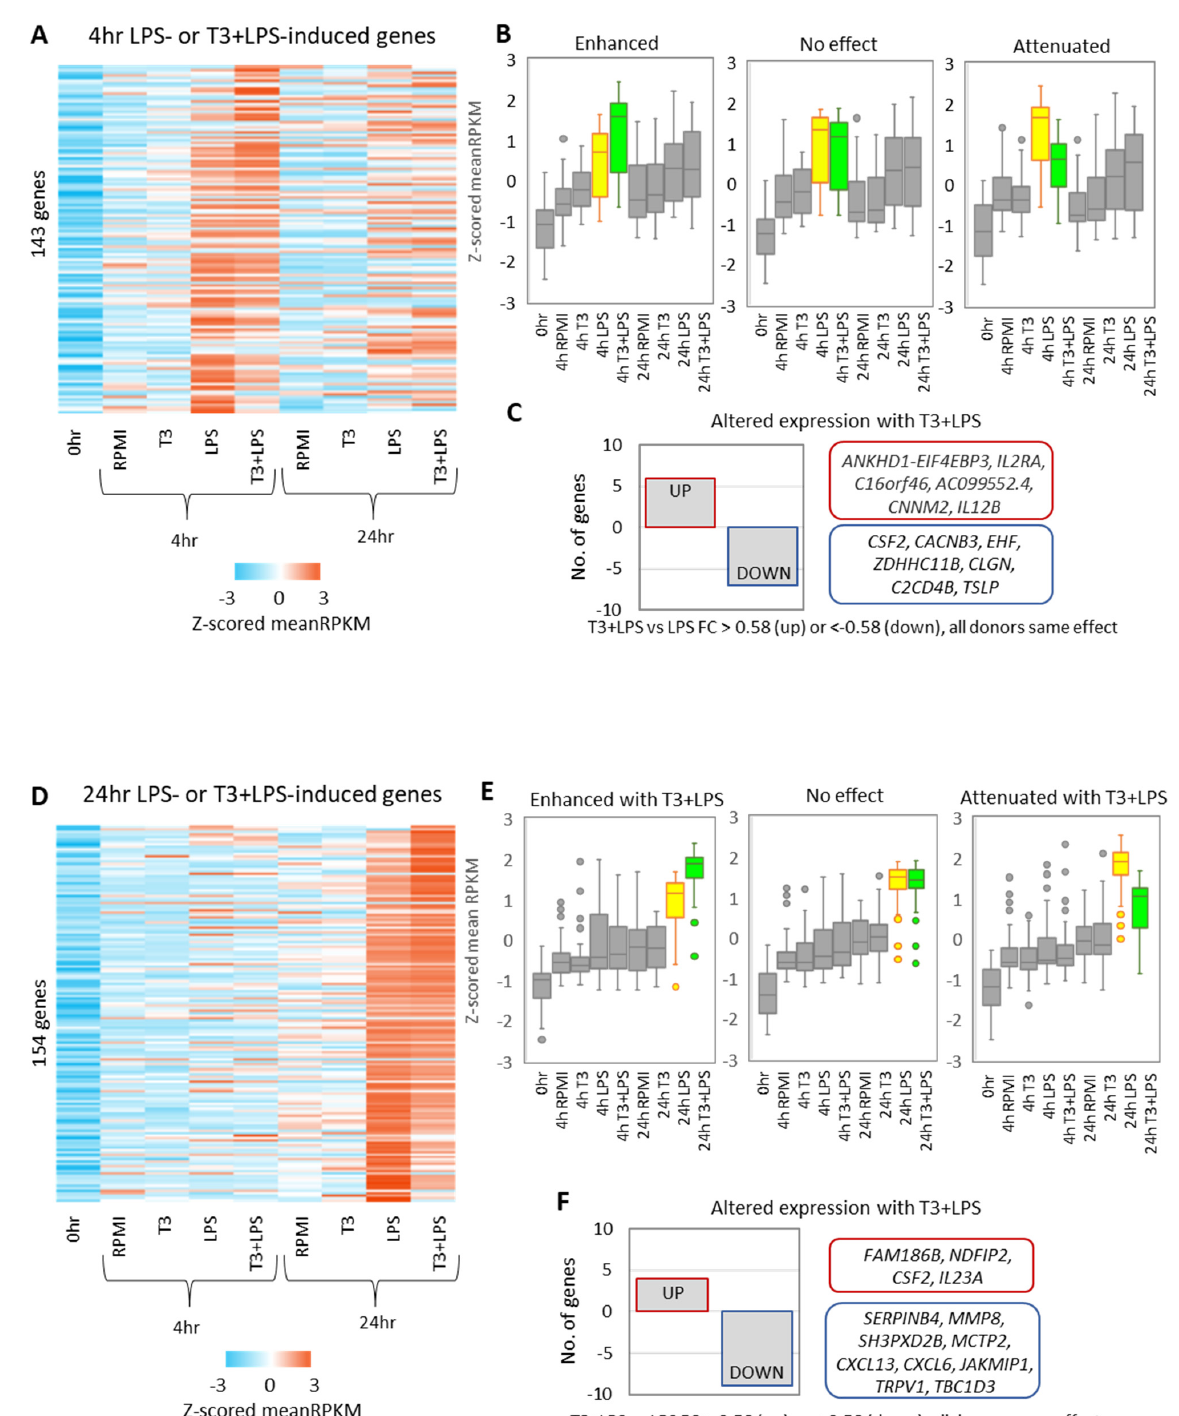
Figure 4. The presence of T3 has opposing effects on expression of LPS-induced genes. Heatmap showing mean expression of 4 h LPS-induced genes (143 genes) ( A ) and 24 h LPS-induced genes (154 genes) ( D ), ranked by the effect of T3 on expression (mean RPKM T3 + LPS/LPS). Gene lists were divided into 3 equal quantiles and Z-scored mean expression values were plotted in boxplots